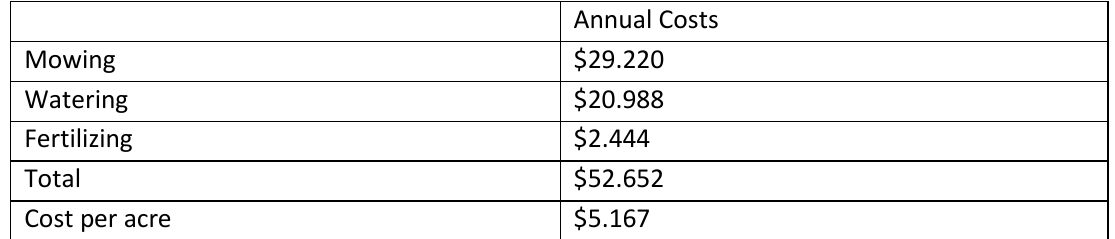
Table 1: The annual costs of maintaining 10.19 acres of total lawn